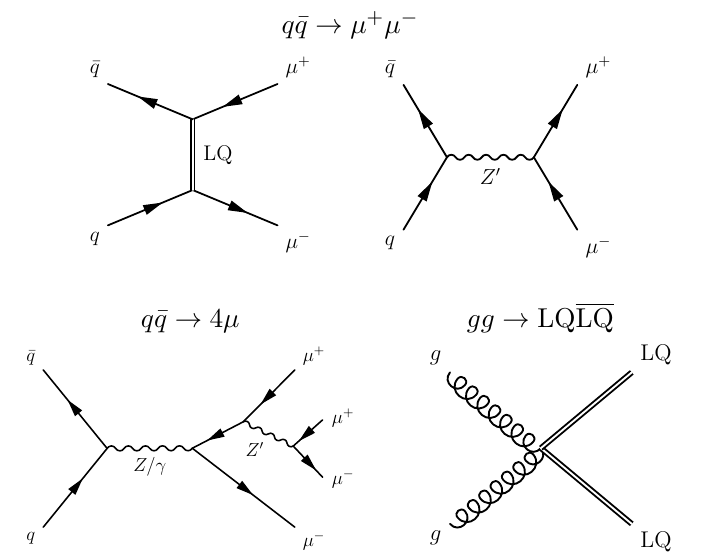
Figure 5 . Sample Feynman diagrams for the partonic processes relevant at hadron colliders. For the scalar leptoquark S 3 one should exchange q ↔ ¯ q